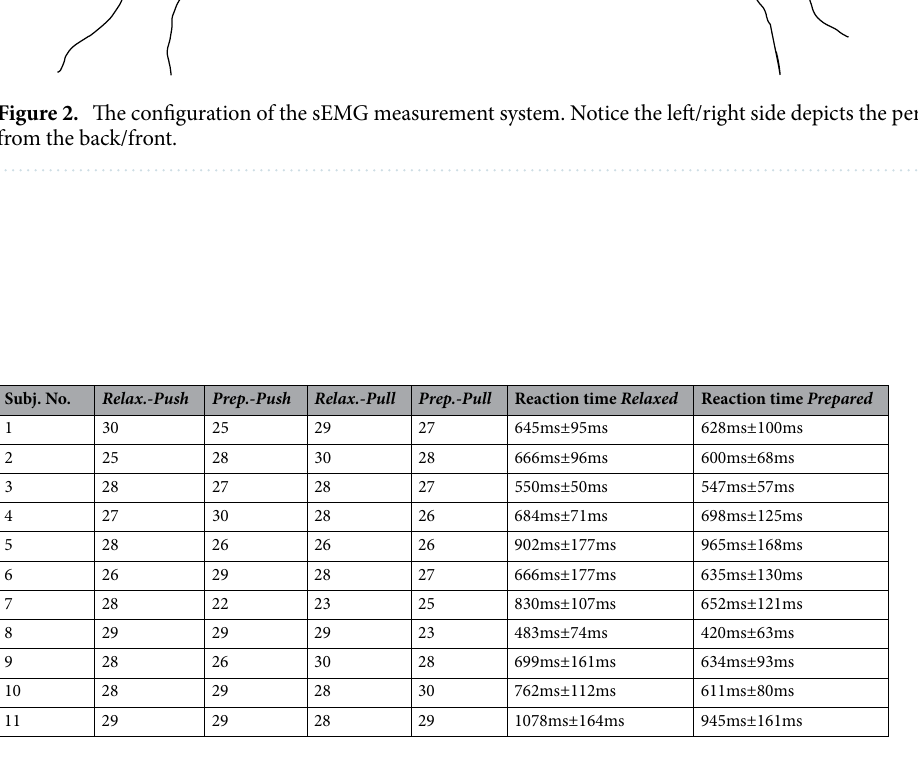
Table 1. The number of valid motion trials for each idle - motion task combination (columns 2-5); and the statistics of the reaction time. As explained in the text, these ”reaction” time data should not be compared with standard PVT